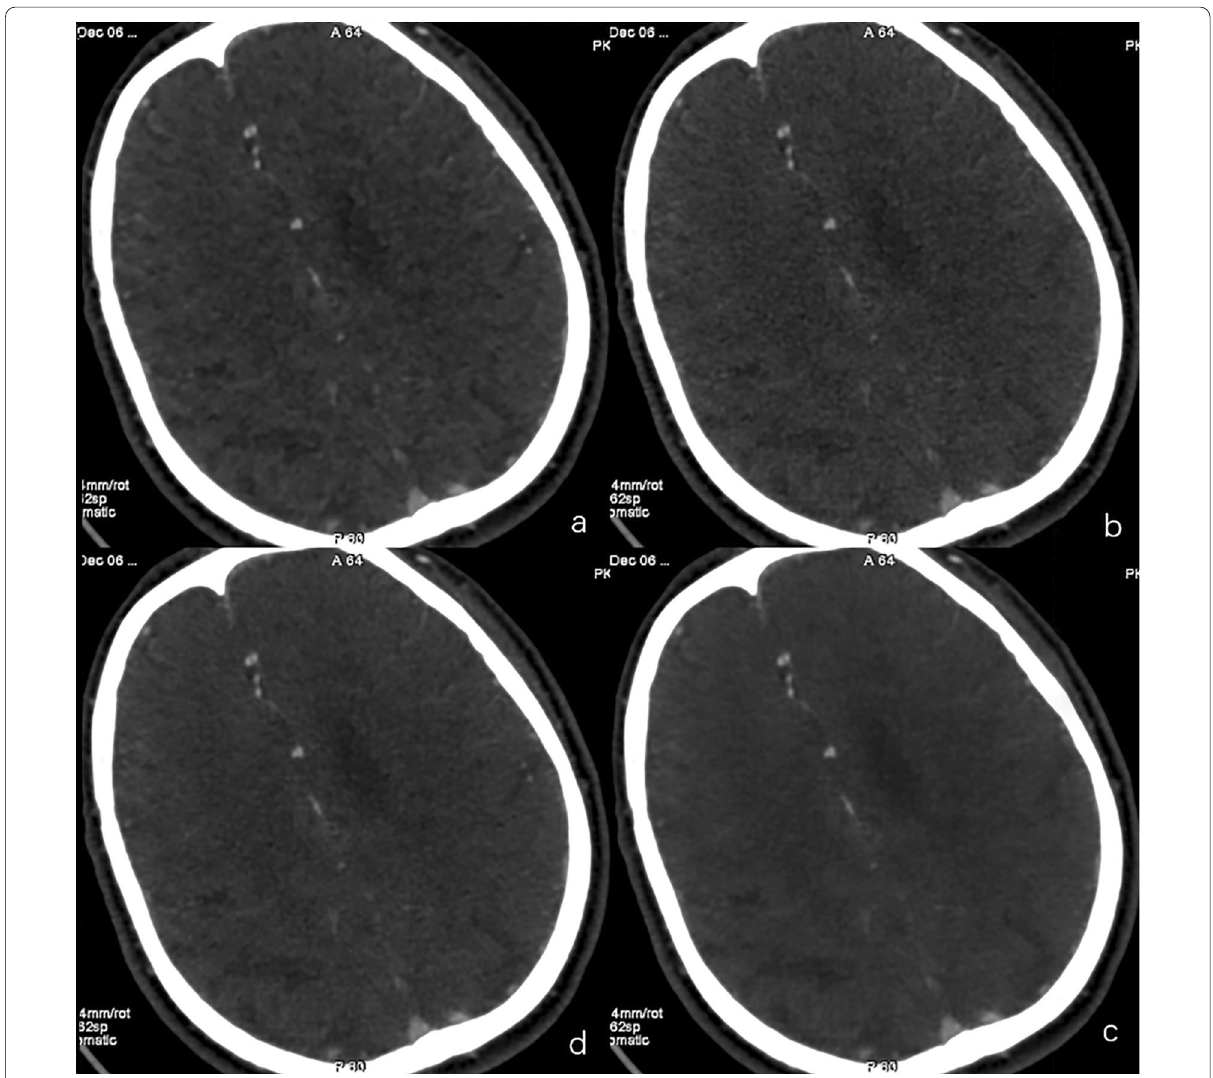
Fig. 2 Qualitative image analysis for image noise and texture between four reconstructed images. A 71-year-old male with carotid artery occlusion. The 80% ASIR-V ( a ), DLIR-L ( b ), DLIR-M ( c ), and DLIR-H ( d ) are shown. The image noise of DLIR-L seems to be similar to that of ASIR-V, but the image of DLIR-M and DLIR-H is obviously better than ASIR-V. The over-smooth “plastic-looking” texture at centrum semiovale the most striking in the ASIR-V image, while the unnatural texture was reduced in all DLIR images, especially in